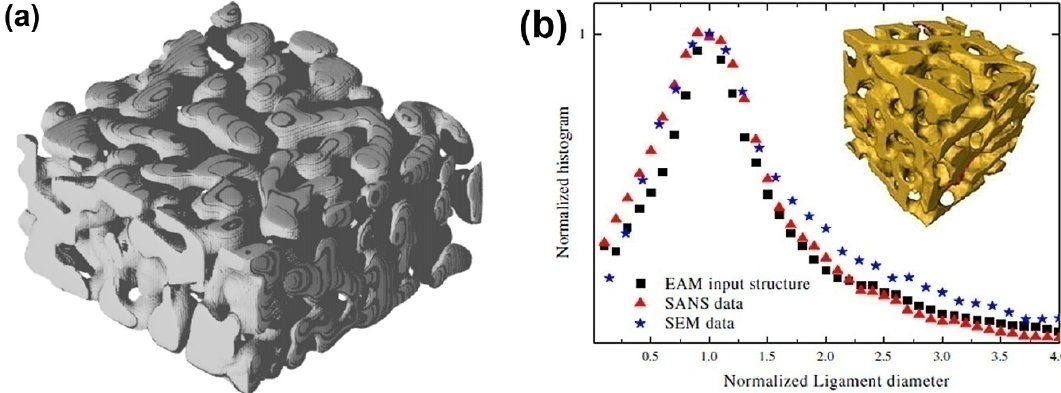
Figure 2. Bicontinuous structure of nanoporous gold: ( a ) Generated by a Monte Carlo model. Reproduced with permission from Reference [56]. (Copyright Elsevier 2013). ( b ) The ligament diameter distribution of the experimental data. Reproduced with permission from Reference [26]. (Copyright Elsevier